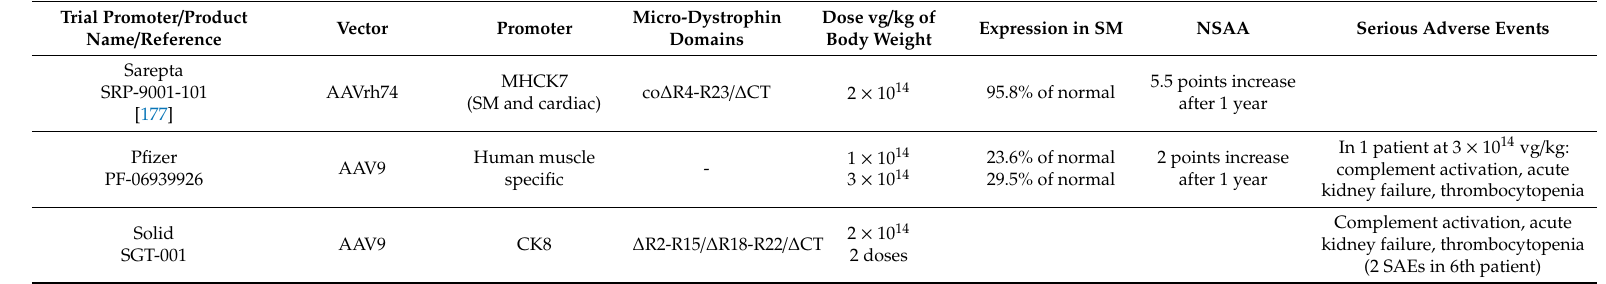
Table 3. Micro-dystrophin clinical trials in DMD patients. NSAA: NorthStar Ambulatory Assessment score, SM: Skeletal